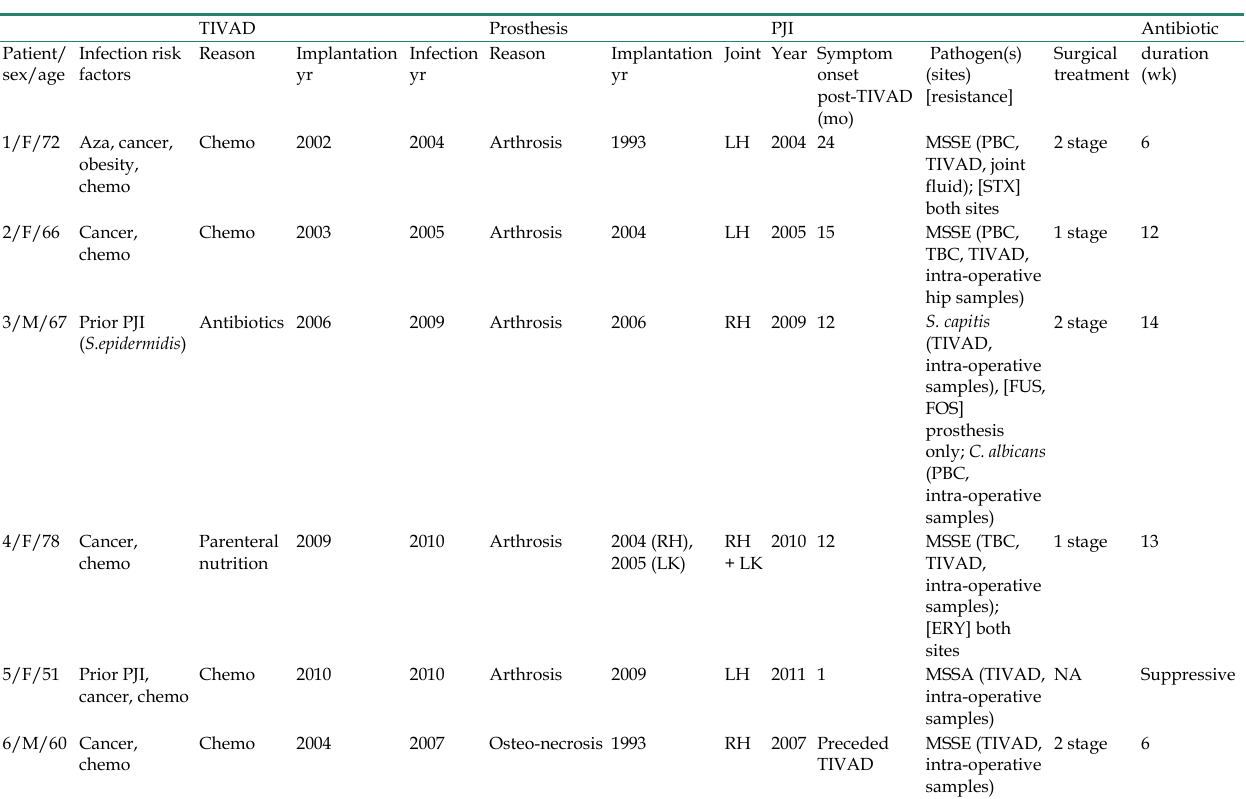
Table 1. Characteristics of the six patients with TIVAD-attributed PJIs. Chemo: chemotherapy; AZA, azathioprine; MSSE: methicillin-susceptible Staphylococcus epidermidis ; MSSA: methicillin-susceptible Staphylococcus aureus ; TBC/PBC: TIVAD/peripheral blood culture; RH: right hip; LH: left hip; LK: left knee. SXT: sulfamethoxazole; FUS: fusidic acid; FOS: fosfomycin; ERY: erythromycin. NA: no available